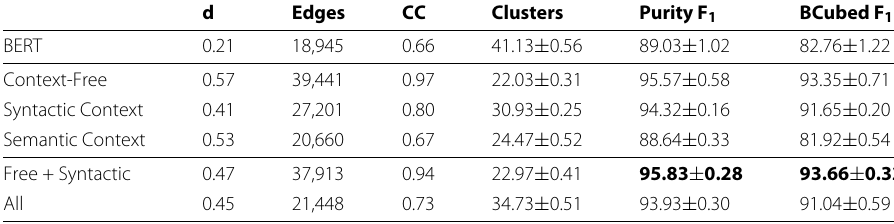
Table 1 Semantic frame induction results achieved using different contextualized representations of verb instances